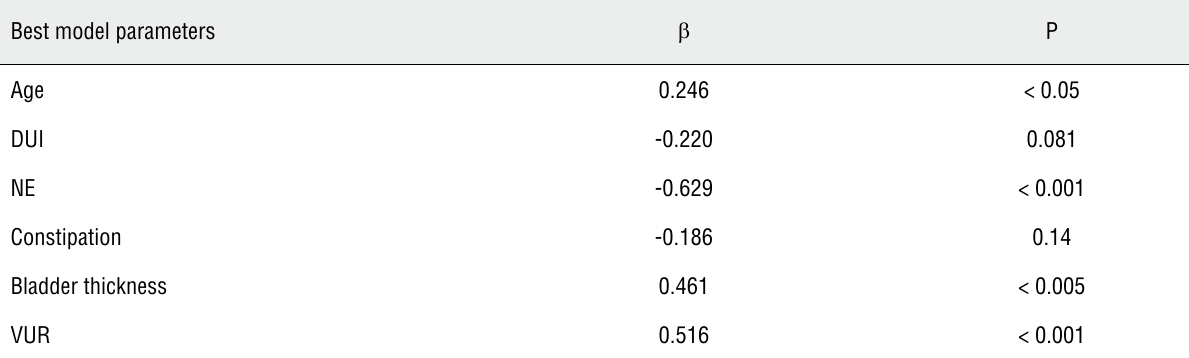
Model 1: Independent DVS predictors: age, urinary tract infections (UTI), daytime urinary incontinence (DUI), nocturnal enuresis (NE), NE+DUI, constipation, renal ultrasound, bladder thickness, renal scarring, vesicoureteral reflux (VUR), uroflow, pelvic muscle elec- tromyography (EMG), postvoid residual (PVR), bladder capacity (adj. R2 = 0.394, p < 0.05)); Model 2: Excluded bladder capacity from M1 (adj. R 2 = 0.419, p< 0.01); Model 3: Excluded renal ultrasound from M2 (adj. R 2 = 0.441, p < 0.01); Model 4: Excluded renal scarring from M3 (adj. R 2 = 0.460, p < 0.005); Model 5: Excluded EMG from M4 (adj. R 2 = 0.477, p < 0.005); Model 6: Excluded NE+DUI from M5 (adj. R 2 = 0.491, p < 0.005); Model 7: Excluded Uroflow from M6 (adj. R 2 = 0.504, p < 0.001); Model 8: Excluded PVR from M7 (adj. R 2 = 0.505, p<0.001); Model 9 - The best model: Excluded UTI from M8 (adj. R 2 = 0.508, p < 0.001); β = standardized beta coefficient of multiple